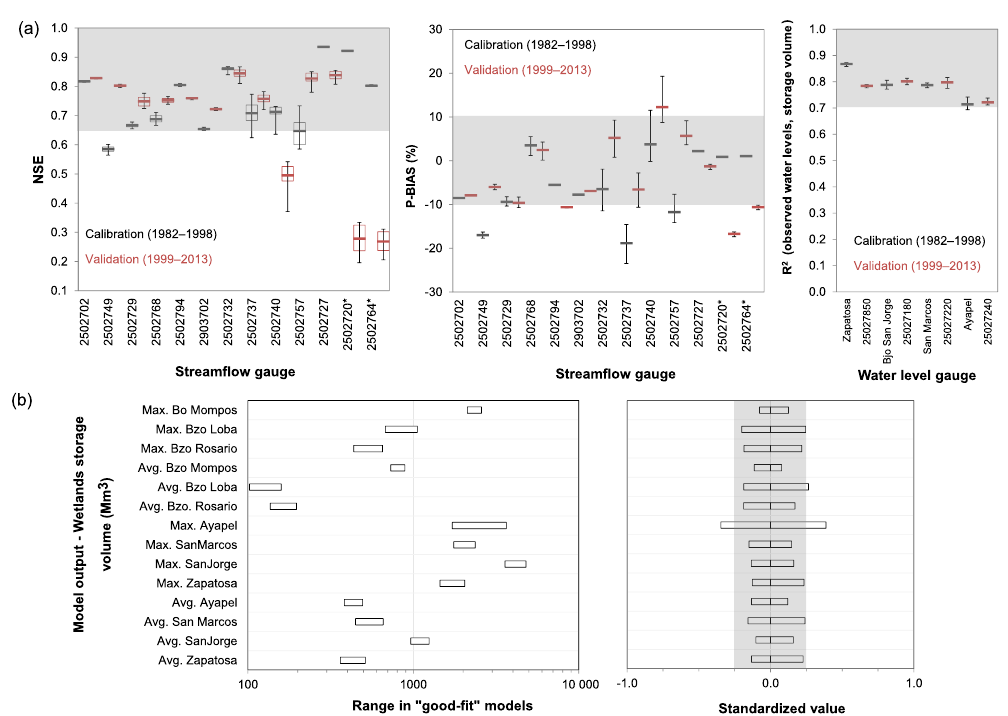
Figure 11. Comparison of the subset of models with highest performance obtained from Monte Carlo calibration: (a) NSE and percentile bias of streamflow, and correlation coefficient of water levels and storage volumes. Acceptance ranges highlighted in grey. (b) Model sensitivity of “good-fit models”, in terms of average and maximum volume storage in the main floodplain sub-units of the Mompós